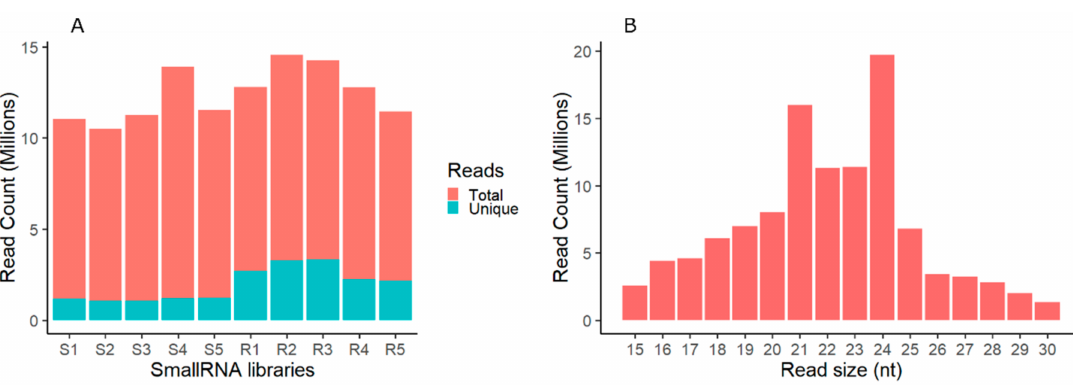
Figure 1. Tripogon loliiformis small RNA reads distribution. ( A ) Pre-processed reads distribution in shoot and root small RNA libraries; ( B ) overall reads distribution by size. S1–S5, R1–R5 represent shoot and root libraries at Hydrated (1), 60% RWC (2), 40% RWC (3), <10% RWC (4), and 48 h after rehydration (5),